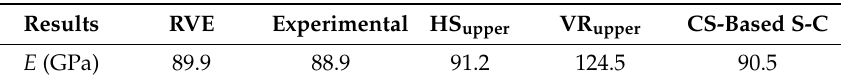
Table 2. Comparison of elastic moduli with analytical models and experimental results. HS upper , VR upper , and CS-based S-C denote the Hashin–Shtrikman and Voight–Reuss upper bounds, and the composite sphere-based self-consistent scheme, respectively